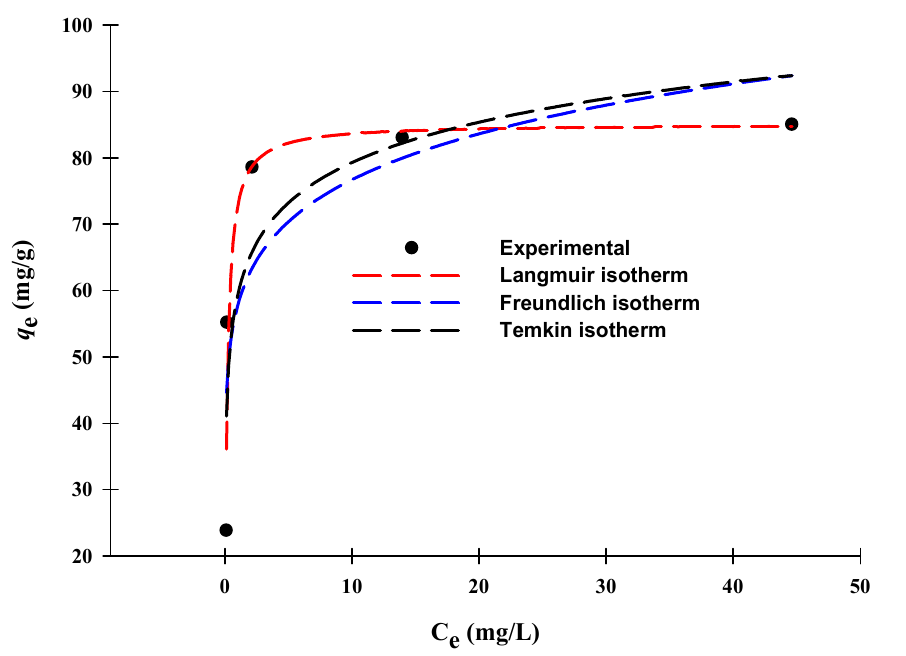
Figure 8. Langmuir, Freundlich, and Temkin nonlinear adsorption isotherms for MB adsorption by BWAC. Table 7. Isotherm parameters and correlation coefficient of different models. Table 8. Comparison study of activated carbon prepared from different